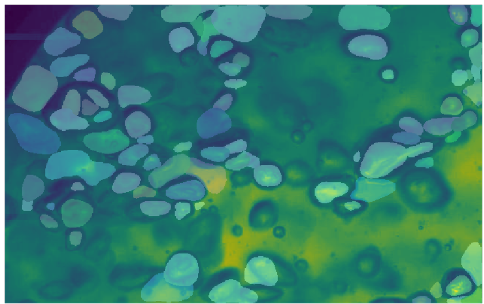
Figure 13. Bubble segmentation using pre-trained